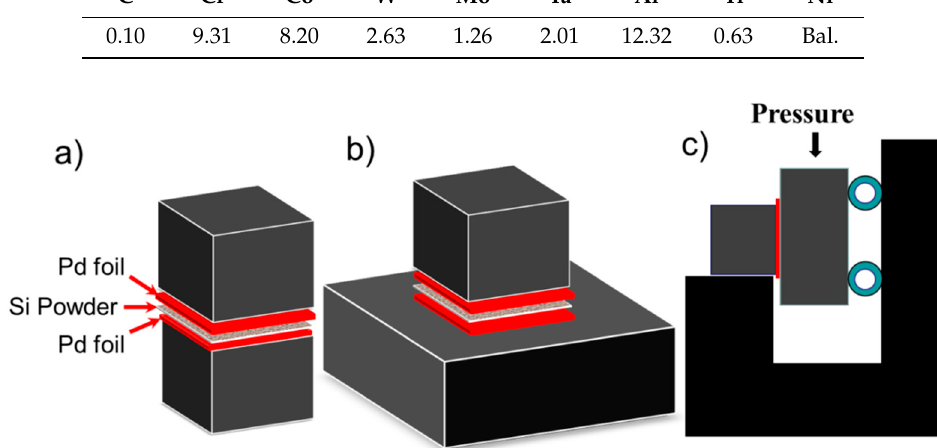
Figure 1. ( a ) The assembling block for microstructural examination, ( b ) the assembling block for mechanical testing, and ( c ) schematic of shear testing experiment.